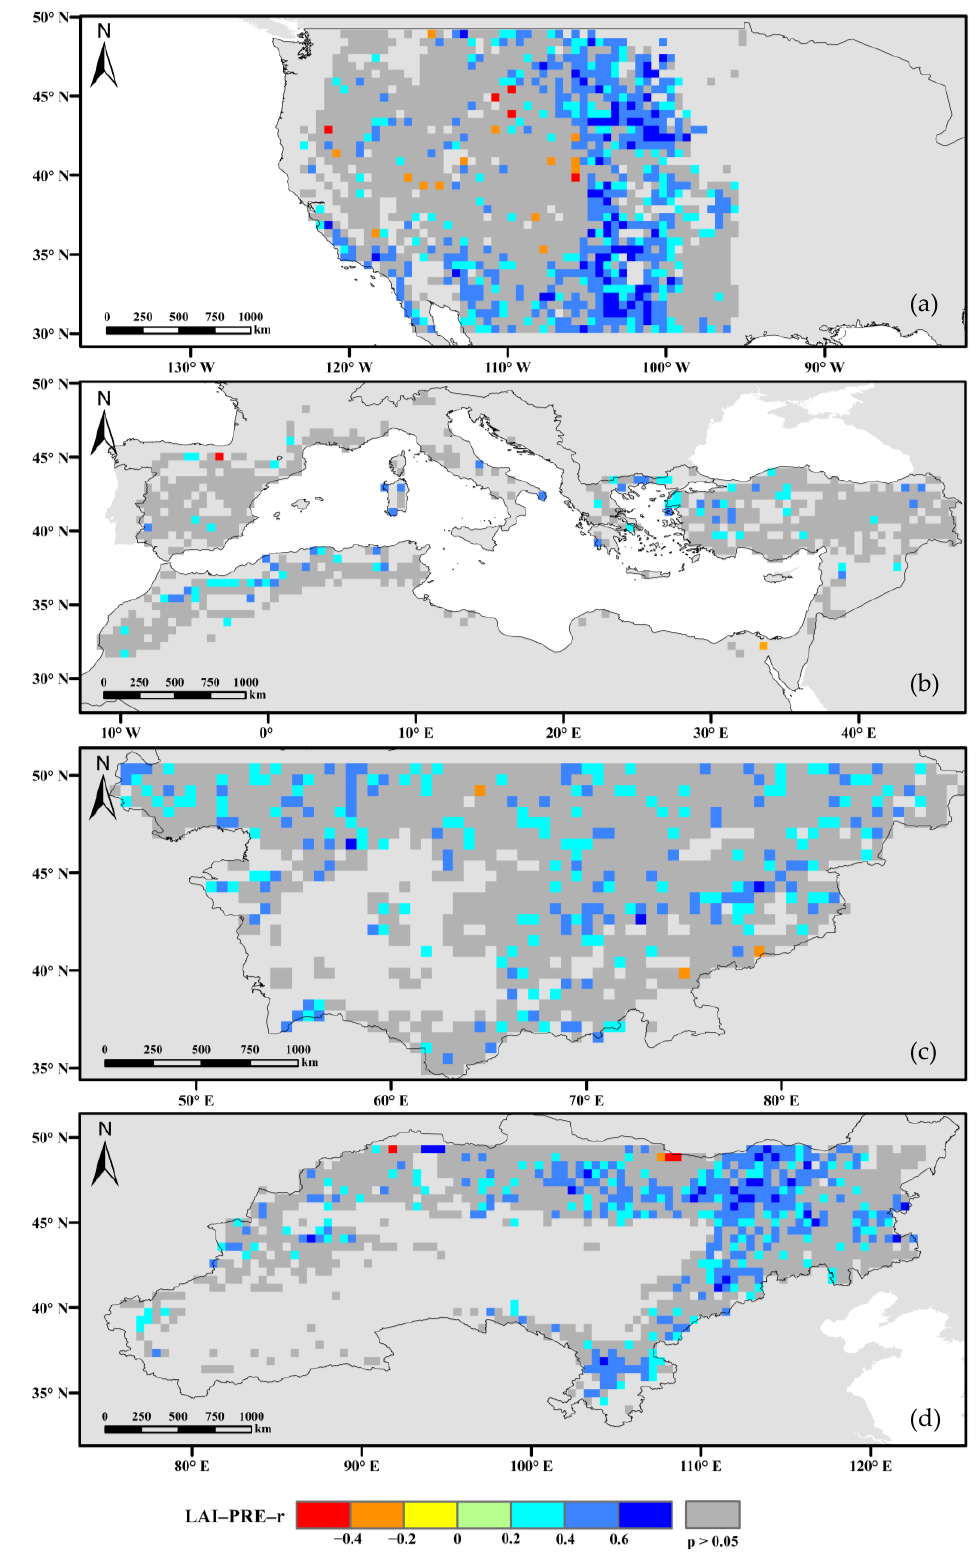
Figure 10. Relationship between the LAI and PRE from 1981 to 2018 ( p < 0.05) ( a ) North America, ( b ) Mediterranean region, ( c ) Central Asia, and ( d ) East Asia.